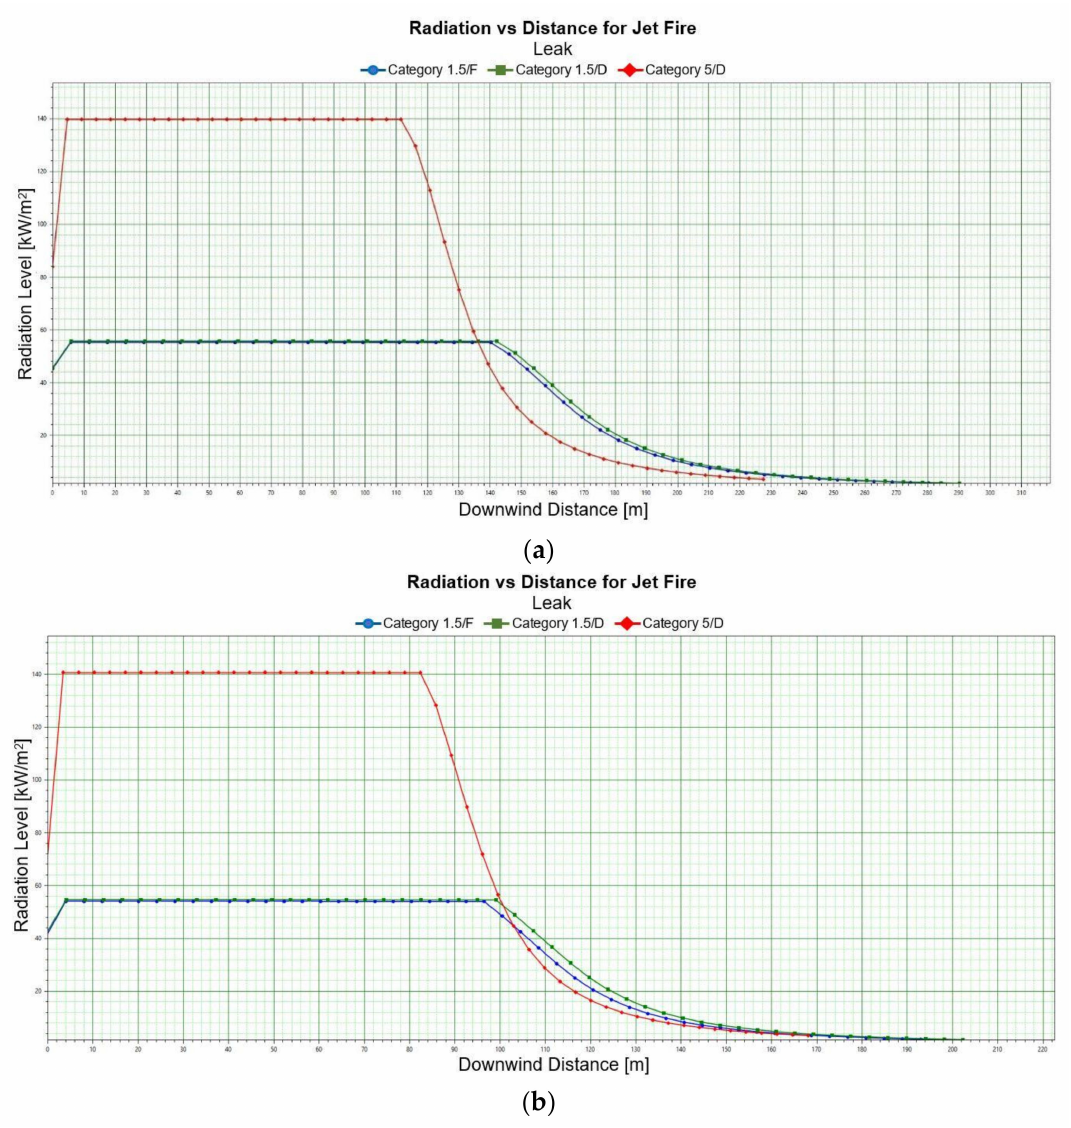
Figure 5. ( a ). Radiation vs. distance, jet fire, LNG-Light 1 m, winter. ( b ). Radiation vs. distance, jet fire, LNG-Heavy 1 m,